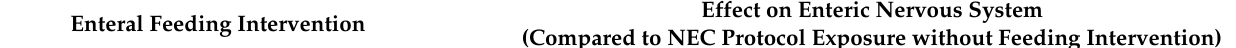
Table 13. Effect of enteral feeding interventions that affect the enteric nervous system in experimental animal models of NEC. Effect on Enteric Nervous System Enteral Feeding Intervention (Compared to NEC Protocol Exposure without Feeding Intervention) Hormone/growth factor/vitamin-based interventions